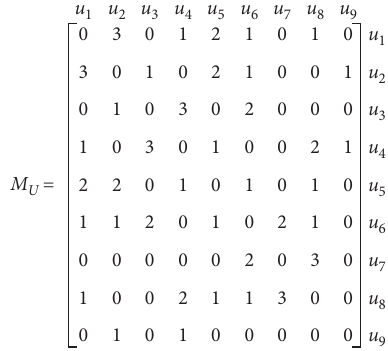
Figure 3: An example user similarity